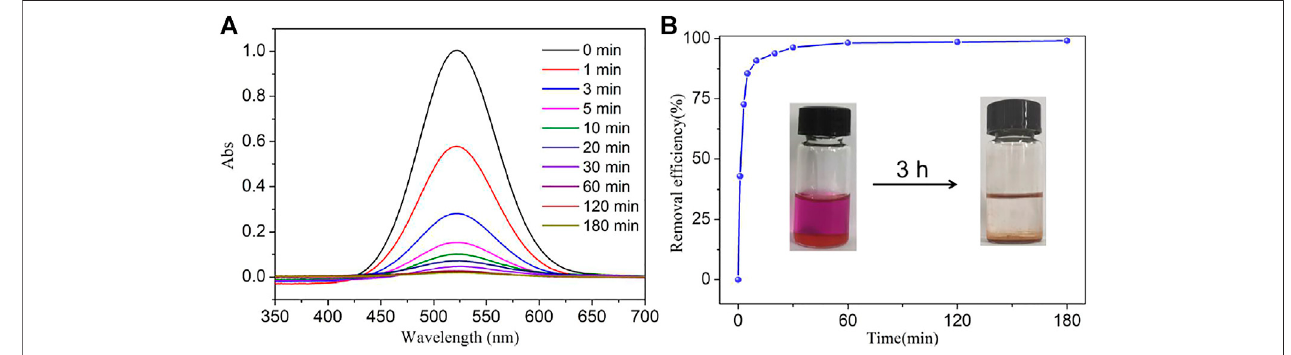
FIGURE2 | (A) Temporal evolution ofUV – Vis absorption spectra for the adsorption of iodine by NS-1 in cyclohexane and (B) the rateof iodine adsorptionin NS-1 in cyclohexane ( C 0 = 300 mg/L).